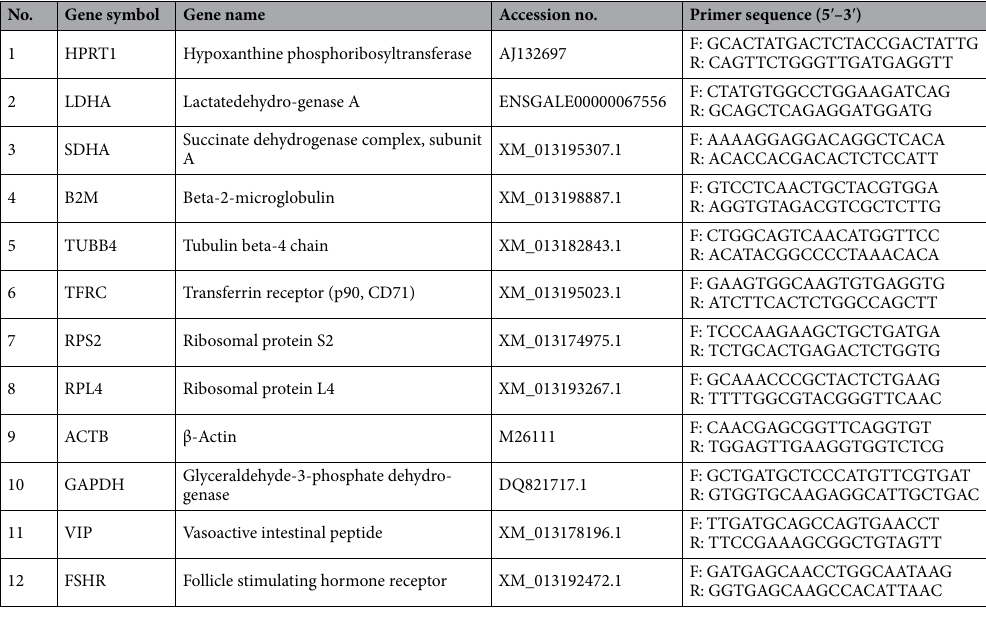
Table 3. Primer information of candidate internal reference genes and target